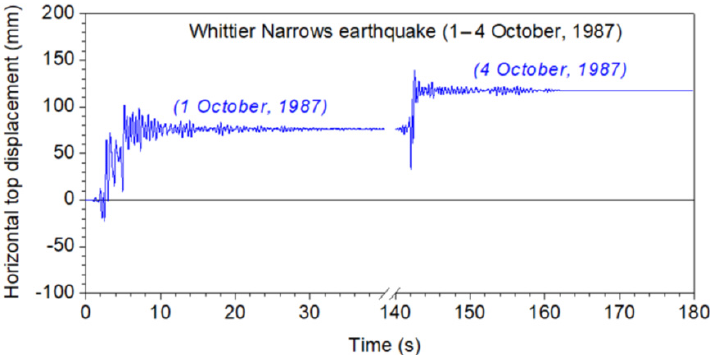
Figure 16. Fixed-base platform under the Whittier Narrows earthquakes (1–4 October 1987): time history of the horizontal top displacement.